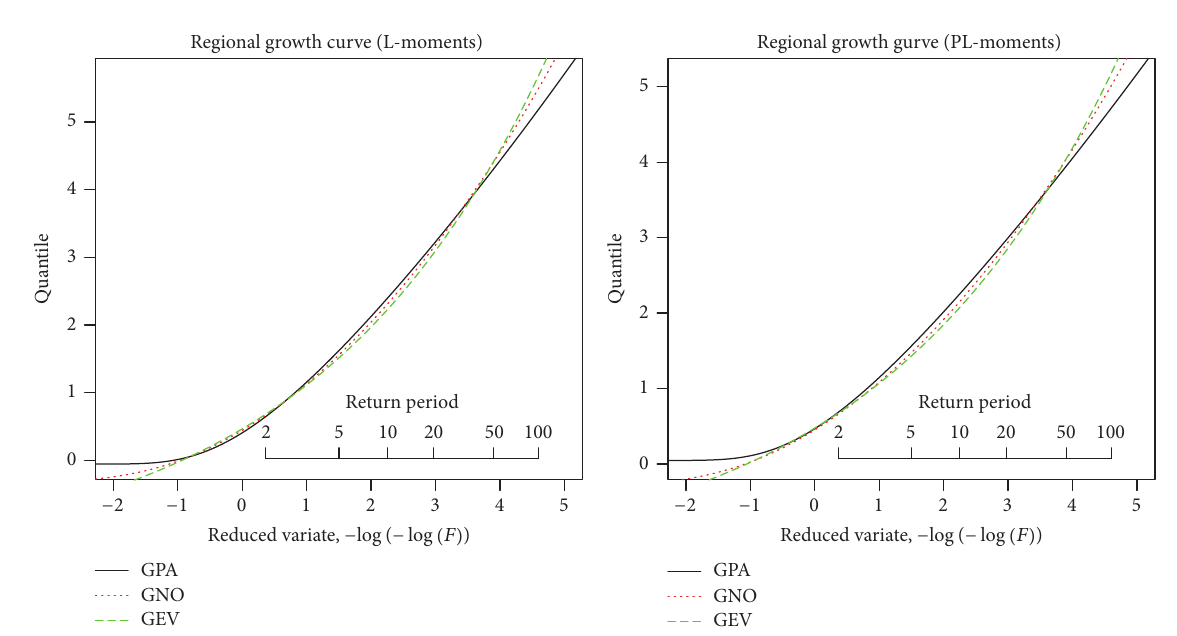
Figure 3: L-moments and PL-moments regional growth